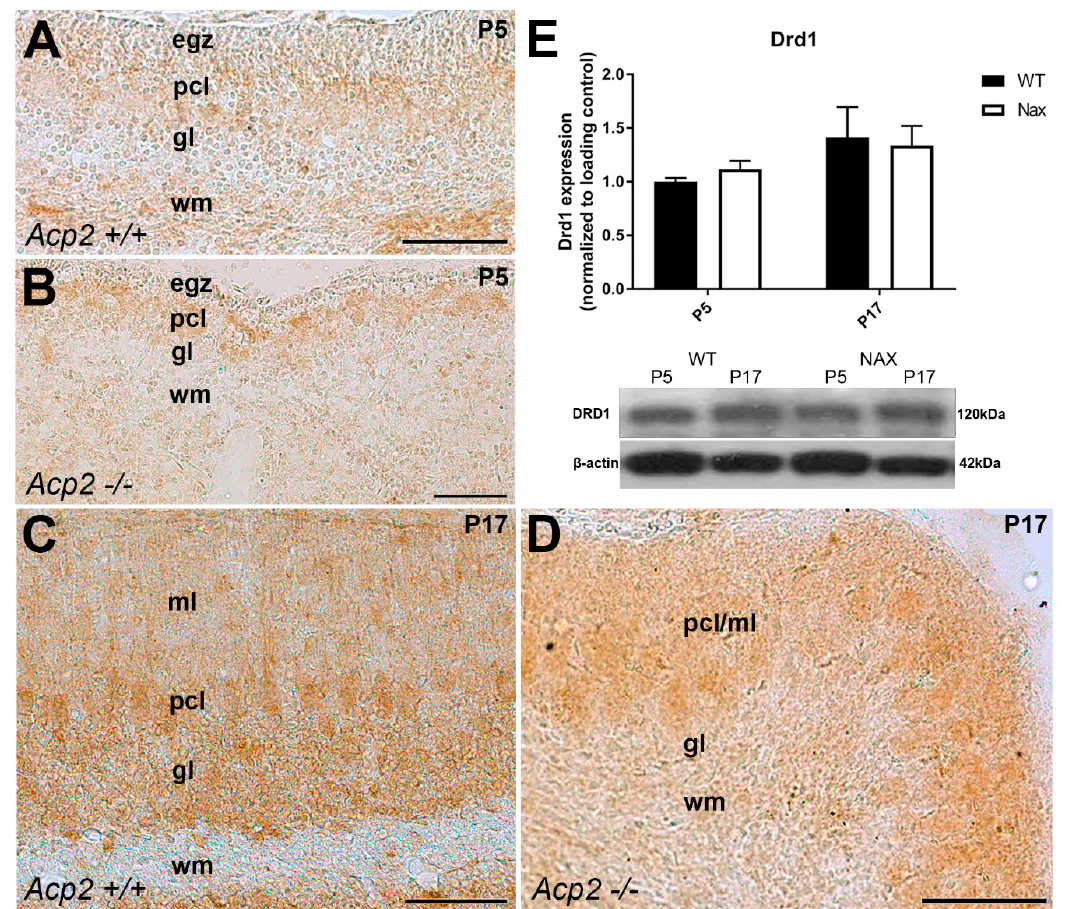
Figure 2. Frontal sections of wt and nax mouse cerebella: DRD1 expression at P5 and P17. ( A ) Immunoperoxidase staining for DRD1 in the wt cerebellum on P5 shows the immunoreactivity in the Purkinje cell layer (Pcl) and white matter (wm) but not in the external germinal zone (egz) and granular layer (gl). ( B ) Immunoperoxidase staining for DRD1 in the nax cerebellum shows similar immunoreactivity as in the wt littermates at P5. ( C ) DRD1 immunostaining of the frontal sections of the wt cerebellum at P17 shows immunoreactivity in the Purkinje cell (PC) somata, the Pcl, and dendrites in the molecular layer (ml) and in the gl but not in the wm. ( D ) DRD1 immunostaining of the frontal sections of the nax cerebellum on P17 shows immunoreactivity in the PCs in the ml/Pcl. ( E ) Western blot analysis of whole cerebellar lysates revealed no significant differences in DRD1 expression between wt and nax cerebella at P5 and P17 (wt: n = 3 and nax : n = 3). The data in the bar graphs are presented as the means of three independent experiments ± SEM, and statistical analysis was performed using a two–way ANOVA. P; postnatal. Scale bars: 100 μ m in A, B, C, and D.